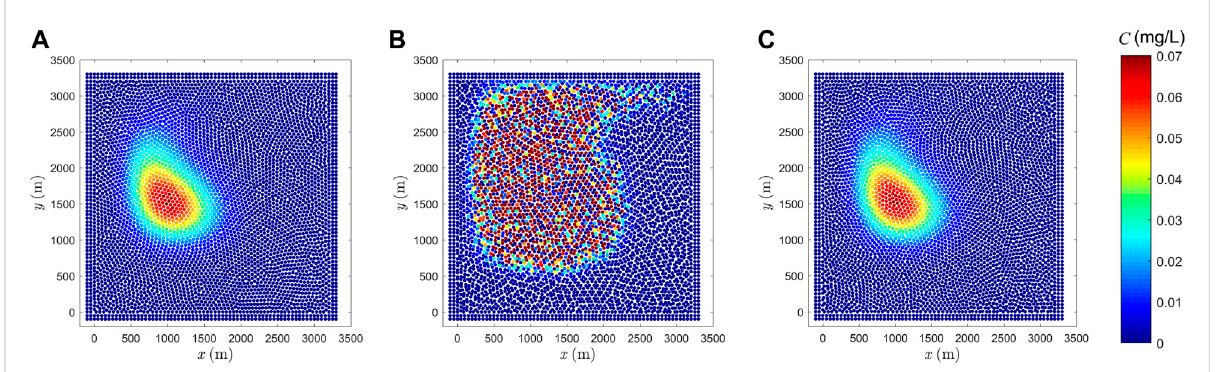
FIGURE 14 SimulationresultsbySPHwithPSTusing (A) mixedparticleposition n p and n a and L p (cid:2) 0 . 4, (B) advectedparticleposition n a and L p (cid:2) 0 . 4,and (C) advected particle position n a and L p (cid:2) 0 .